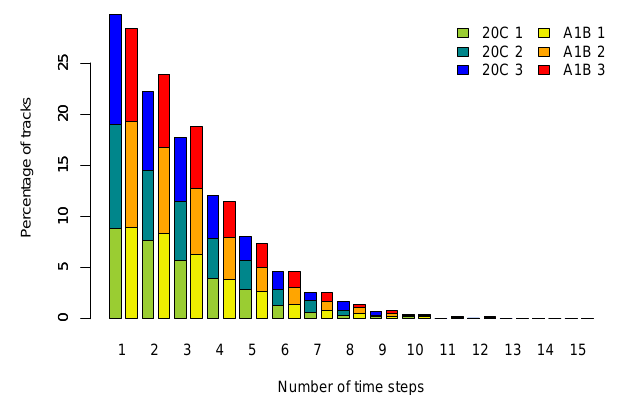
Figure 6. Potential storm surge duration distribution (in %) with respect to the number of time steps which exceed the critically ef- fective wind component for the three 20C runs (1901–2000, green to blue) and the three A1B runs (2001–2100, yellow to